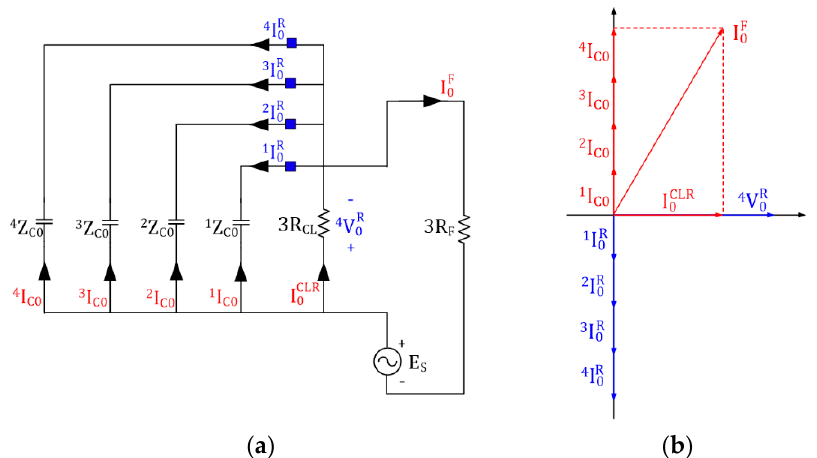
Figure 5. Simplified sequence network and phasor diagram in the case of an SLG fault in a 22 kV busbar: ( a ) simplified sequence network; ( b ) corresponding phasor diagram.